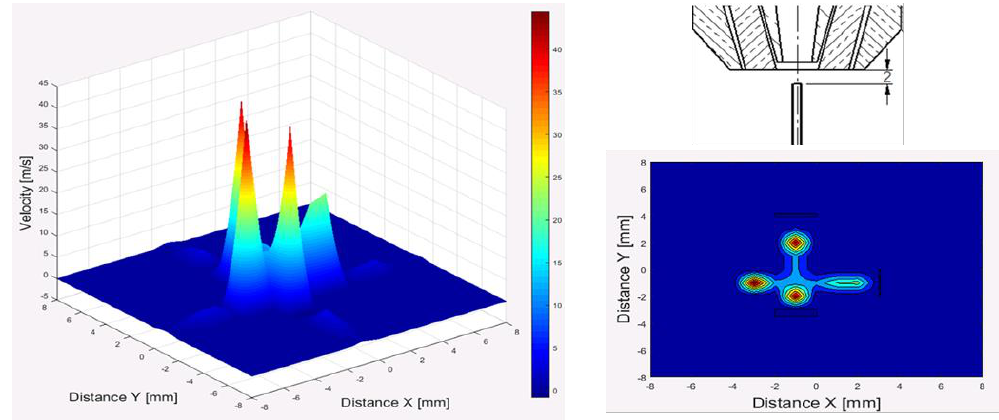
Figure 13: gas velocity measured at 2 mm from the